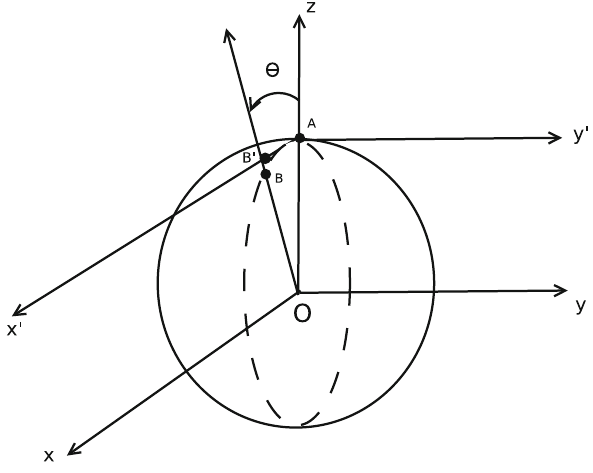
Fig. 1 Inthisplottheobserverislocatedat O .Wecomputethecorrela- tions of CMB observables, such as temperature and Stokes parameters, between two points A and B . The coordinate system is chosen such that point A is at pole and B lies in the x − z plane. The projection of point B on a plane tangent at A is B’. Projection of A itself is at A. Both projected points lie on the x’